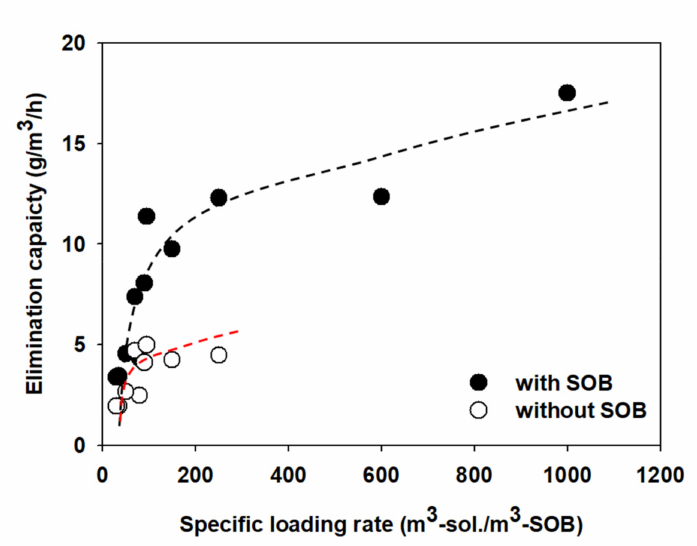
Figure 6. Short-term elimination capacity curves with and without